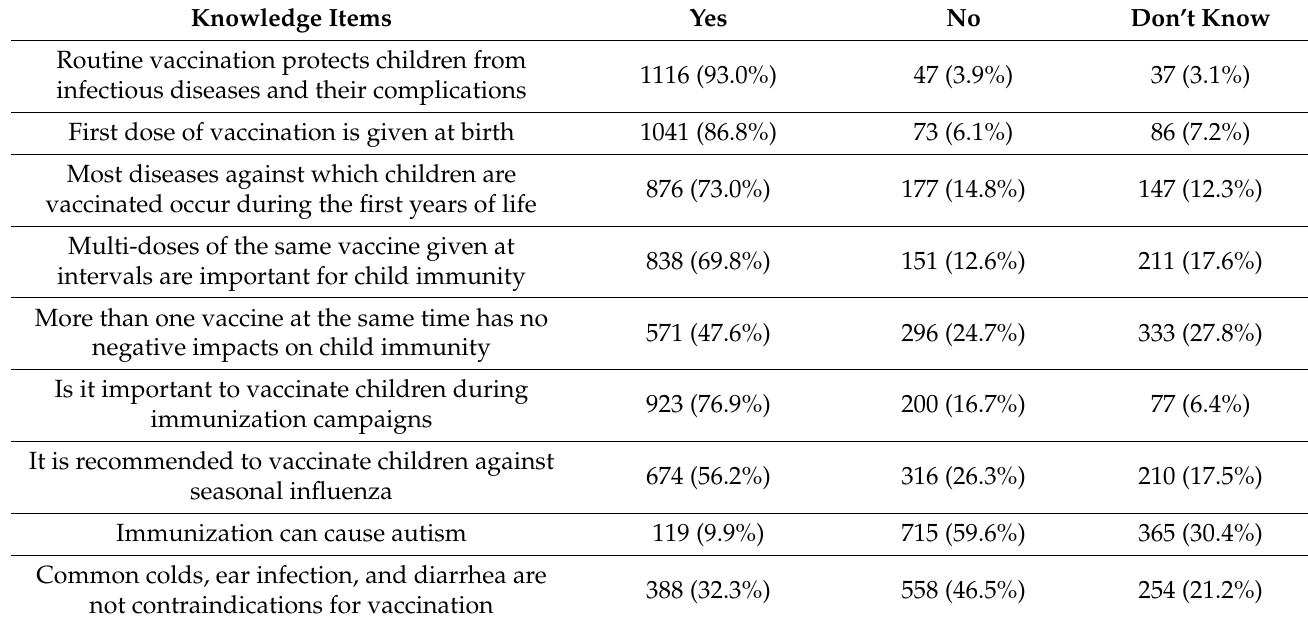
Table 2. Saudi parental knowledge about child